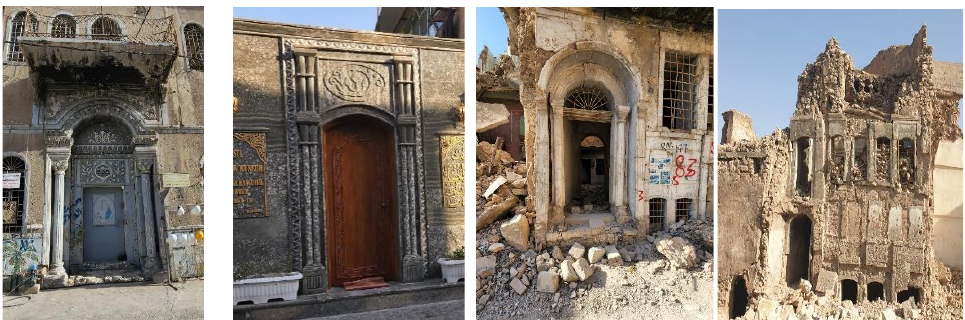
Figure 4. The heritage elements in the old city of Mosul (photo credit: Safaaaldeen ali).